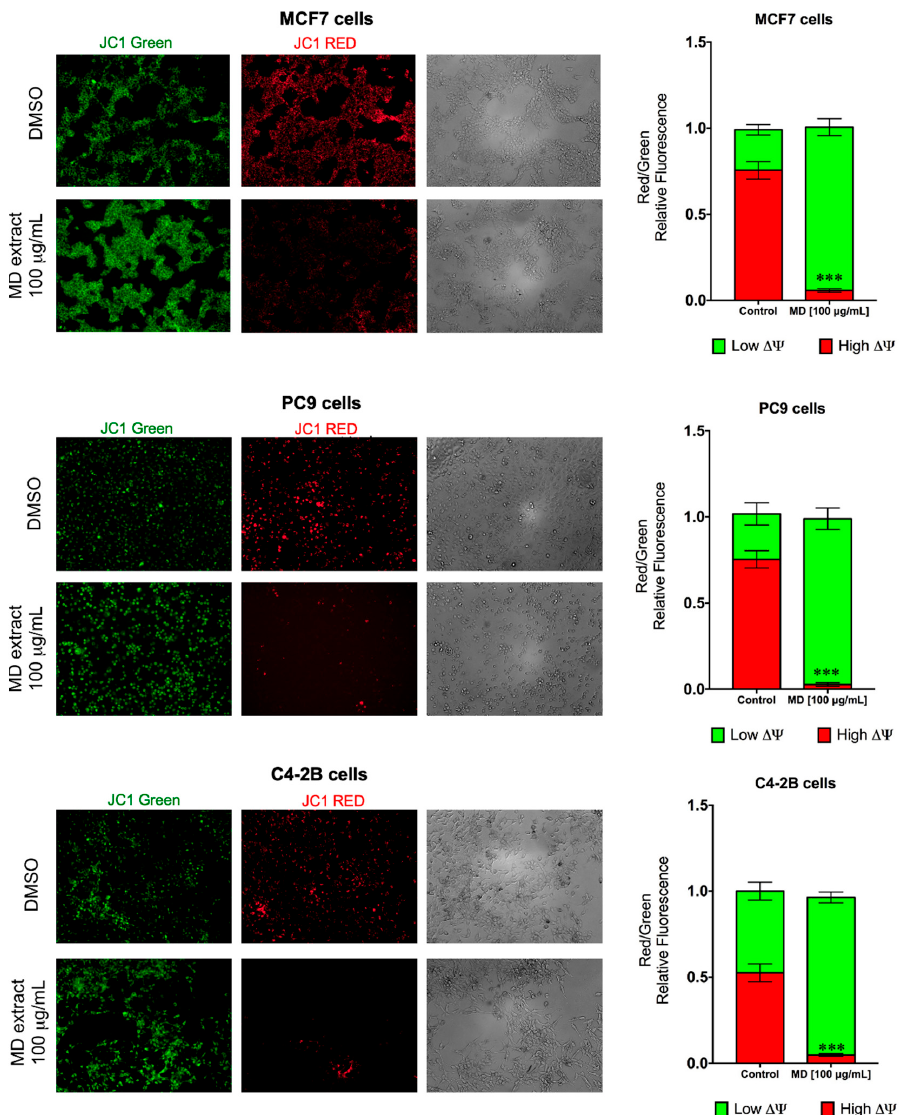
Figure 6. Maytenus disticha extract promotes a mitochondrial membrane potential depolarization. The mitochondrial membrane potential ∆ ψ was evaluated using JC1 assays and epifluorescence microscopy in MCF-7, PC9, and C4-2B cells treated with MD extract (100 µ g / mL) for 24 h. The red color is associated with a high ∆ ψ and the green color with a low ∆ ψ . The data represent the means ± S.D. of three independent experiments performed in triplicate, and statistically analyzed using t student test; (*** p ≤ 0.001). The microphotographs were acquired with an Olympus IX81 DSU microscope (20 ×